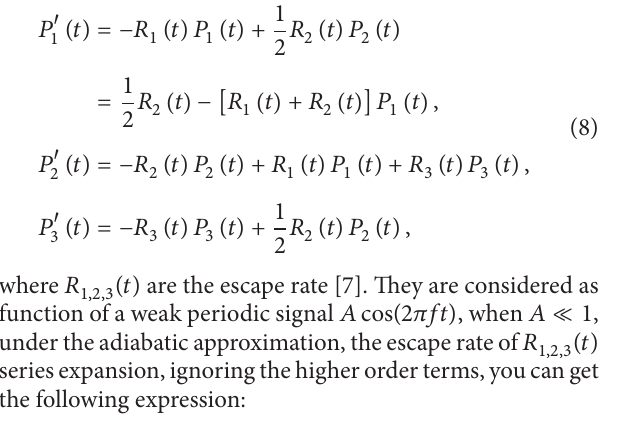
a Gaussian white noise with zero mean and unit variance.